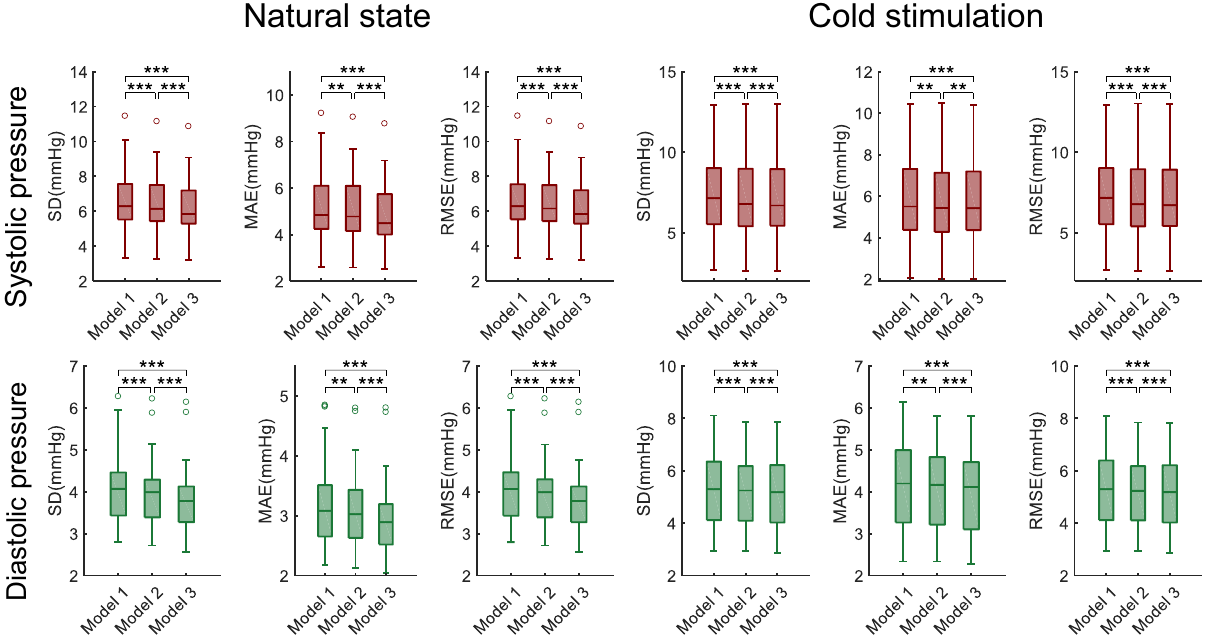
Figure 7. The performance of three models for blood pressure estimation (paired t-test). SD, standard deviation of errors; MAE, mean absolute error; RMSE, root-mean-square error. *, p < 0.05; **, p < 0.01; ***, p <